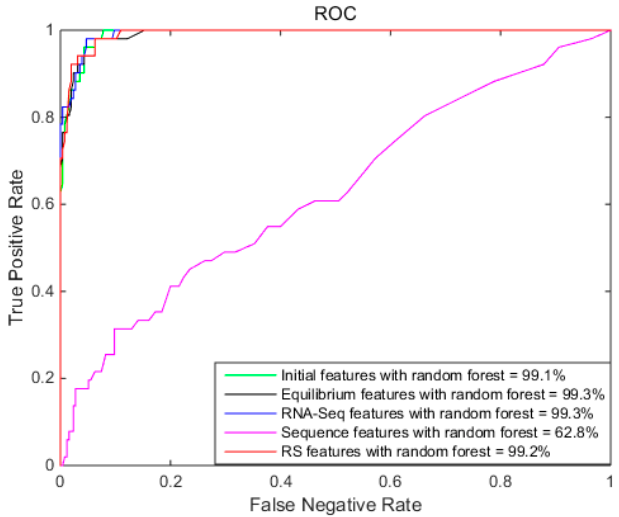
Figure 2 . The receiver operating curves (ROC) of different features with Random Forest, showing the initial features with Random Forest (area under a curve (AUC): 99.1%), equilibrium features with Random Forest (AUC: 99.3%), RNA-Seq features with Random Forest (AUC: 99.3%), sequence features with Random Forest (AUC: 62.8%), and RS features with Random Forest (AUC: 99.2%).